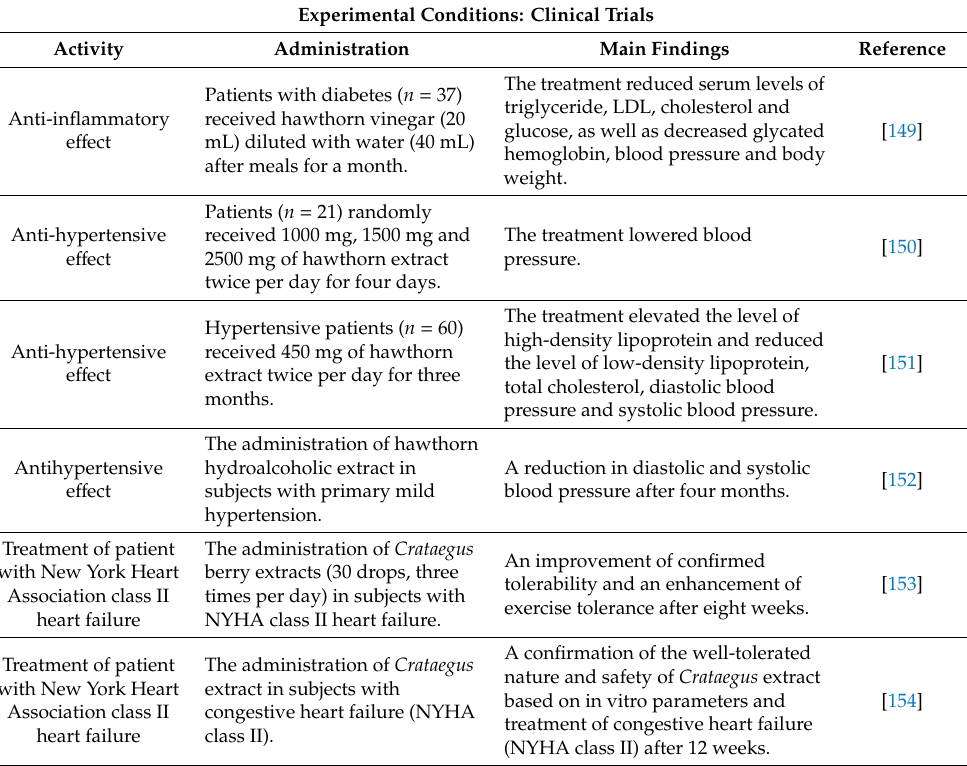
Table 4. Examples of studies in humans involving